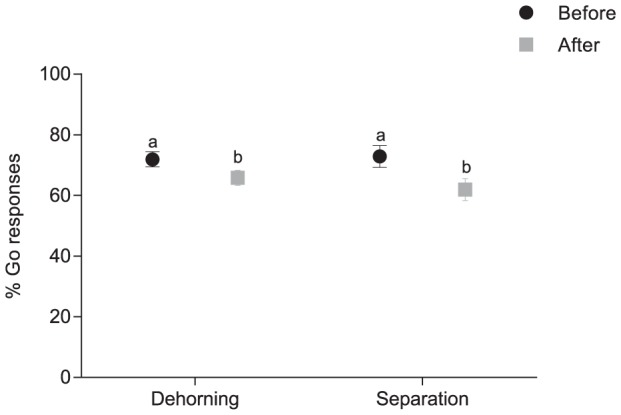
Mean±SE % GO responses to the three ambiguous probe screens (near-positive, intermediate and near-negative) in multiple sessions before dehorning and before separation from dam and multiple sessions after dehorning and after separation from dam.Different letter indicate a statistically significant difference (p>0.05).